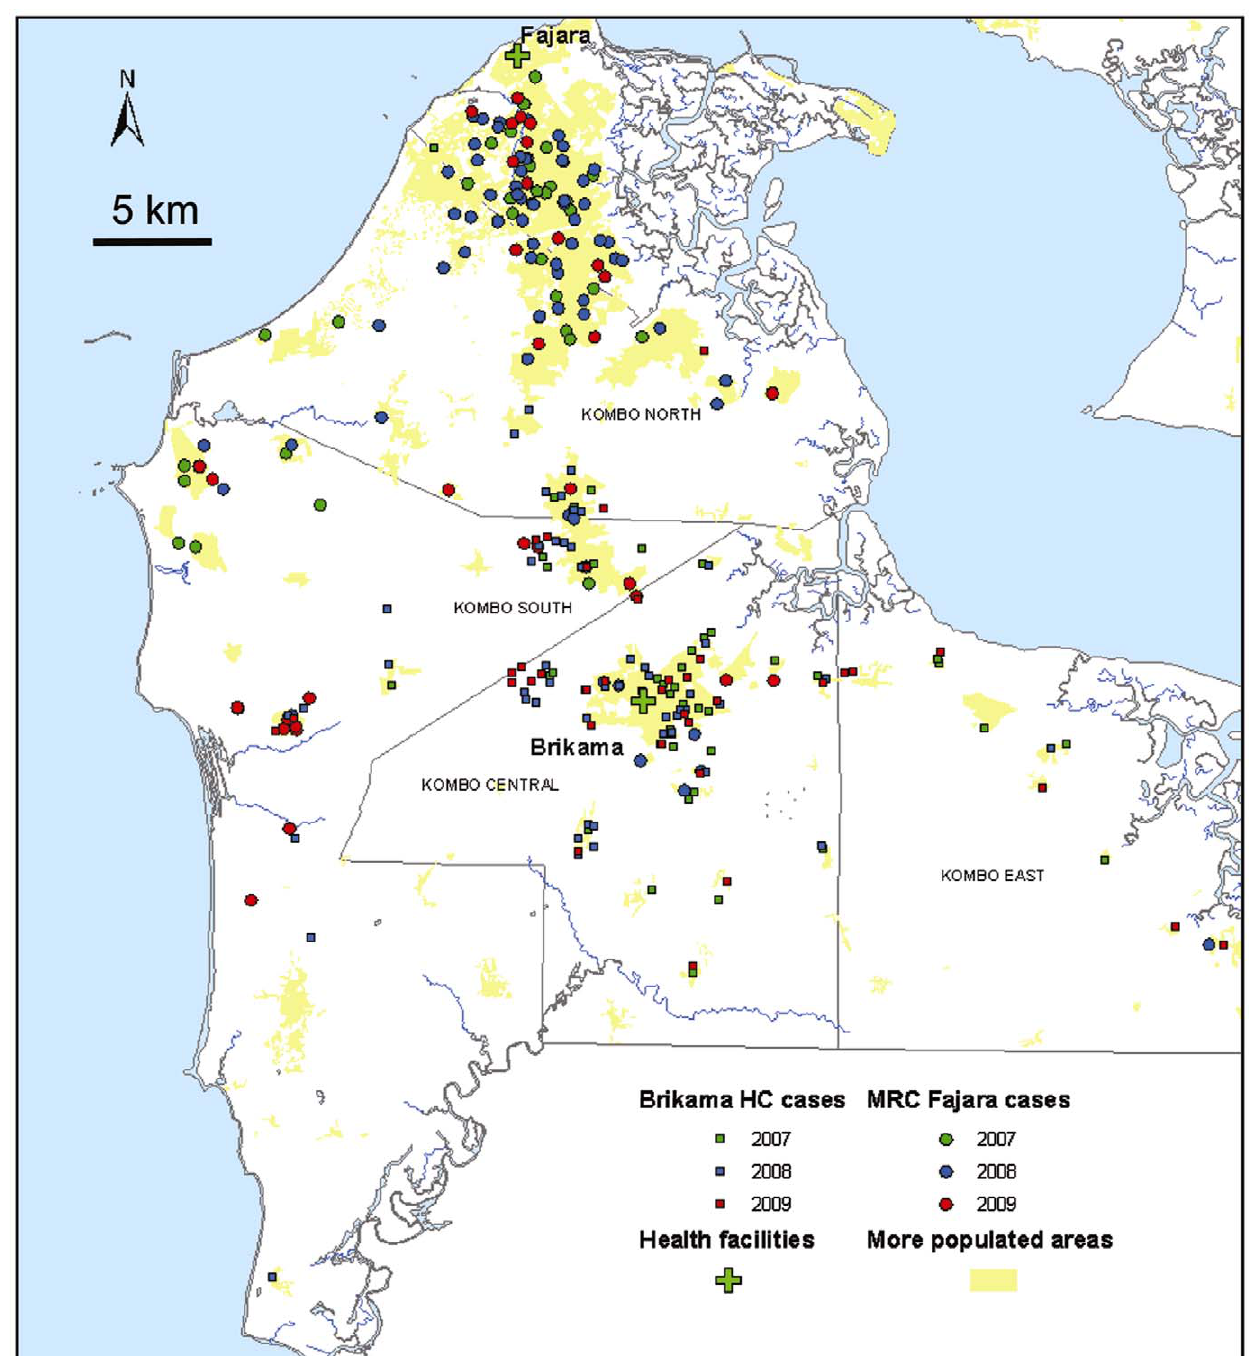
Figure 4. Spatial distribution of cases at two health facilities in the coastal area. Map of household locations of 285 malaria cases sampled from those presenting to the Fajara MRC clinic and Brikama Health Centre in three conseculive malaria seasons 2007 to 2009. Cases presenting to Fajara are represented as circular symbols, and those presenting to Brikama are represented with square symbols.The locations of these two health facilities are shown (green crosses), along with the most densely populated areas (shaded in yellow).